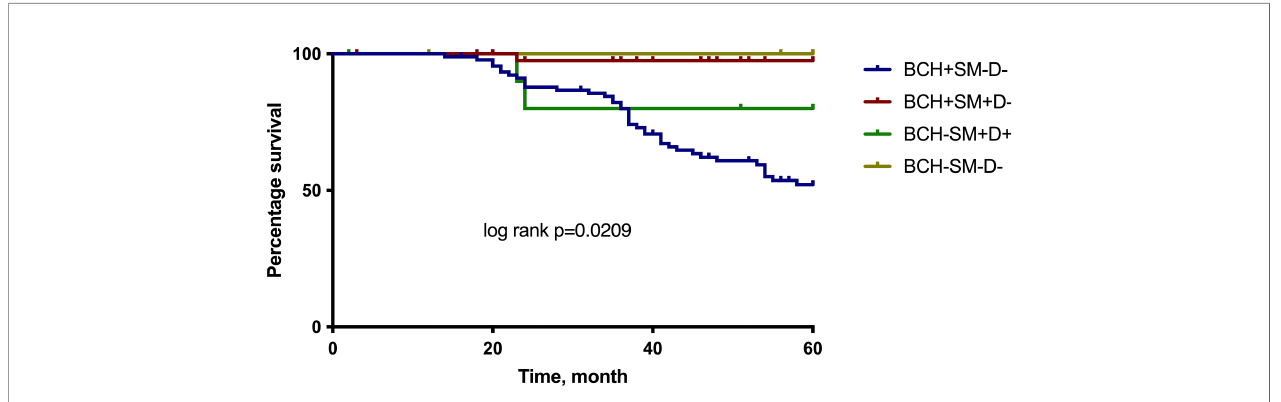
FIGURE 4 | The 5-year MFS for NSCLC patients according to the different types of bronchial lesions. Log rank test. MFS, metastasis-free